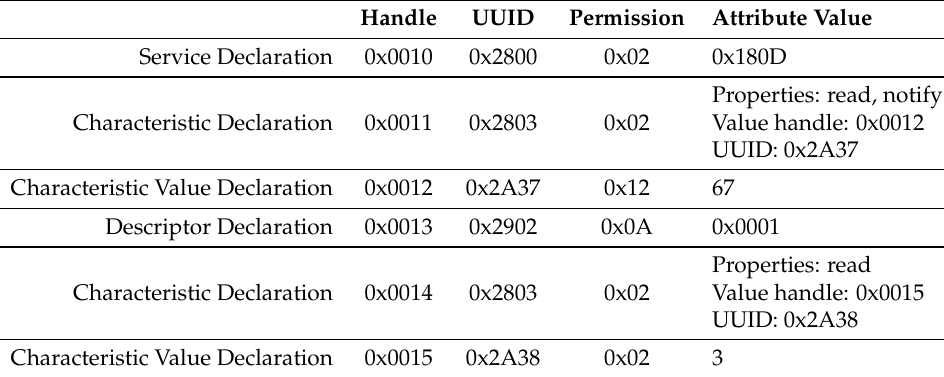
Table 1. Example of a part of an attribute